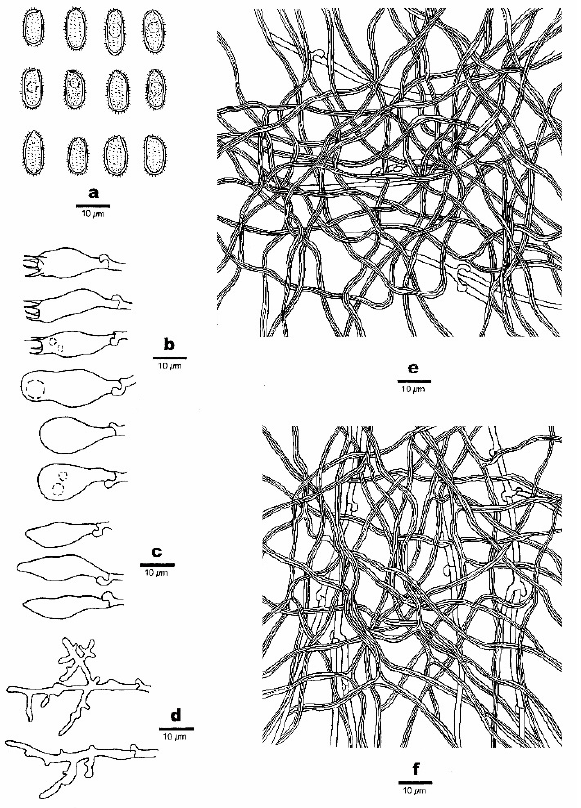
Figure 10. Microscopic structures of Haploporus srilankensis (Holotype). ( a ). Basidiospores. ( b ). Basidia and basidioles. ( c ). Cystidioles. ( d ). Dendrohyphidia. ( e ). Hyphae from subiculum. ( f ). Hyphae from trama.